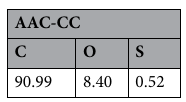
Table 2. Elemental analysis of the